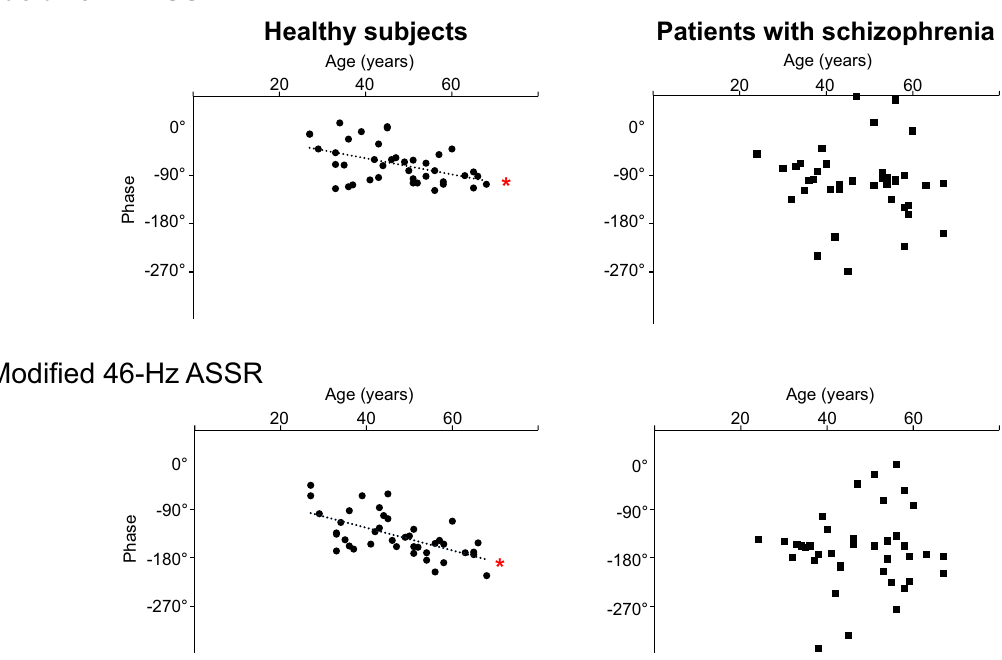
Figure 3. Phase delay with aging. A delayed phase with aging was significant in healthy subjects both in the basic 40-Hz ASSR and in the modified 46-Hz ASSR (left panels of a and b ). This correlation was not observed in either of the ASSRs in patients with schizophrenia (right panels of a and b ). * p <